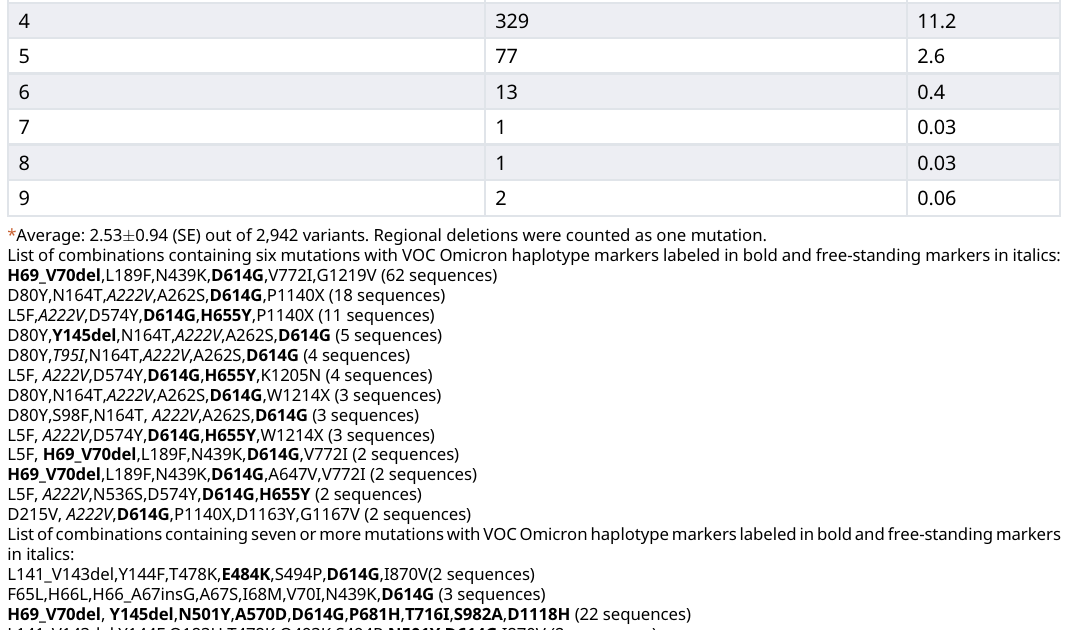
Figure 4 maps the prevalence levels of the VOC Alpha mutations in the combinatorial landscape of 2020. The plot shows a strong bias in the prevalence of mutant combinations holding VOC Alpha markers, supporting a mechanism of VOC emergence via rearrangement rather than selective sweep in the viral population. Thus, going back to the first COVID-19 different prevalence levels in the variant population.